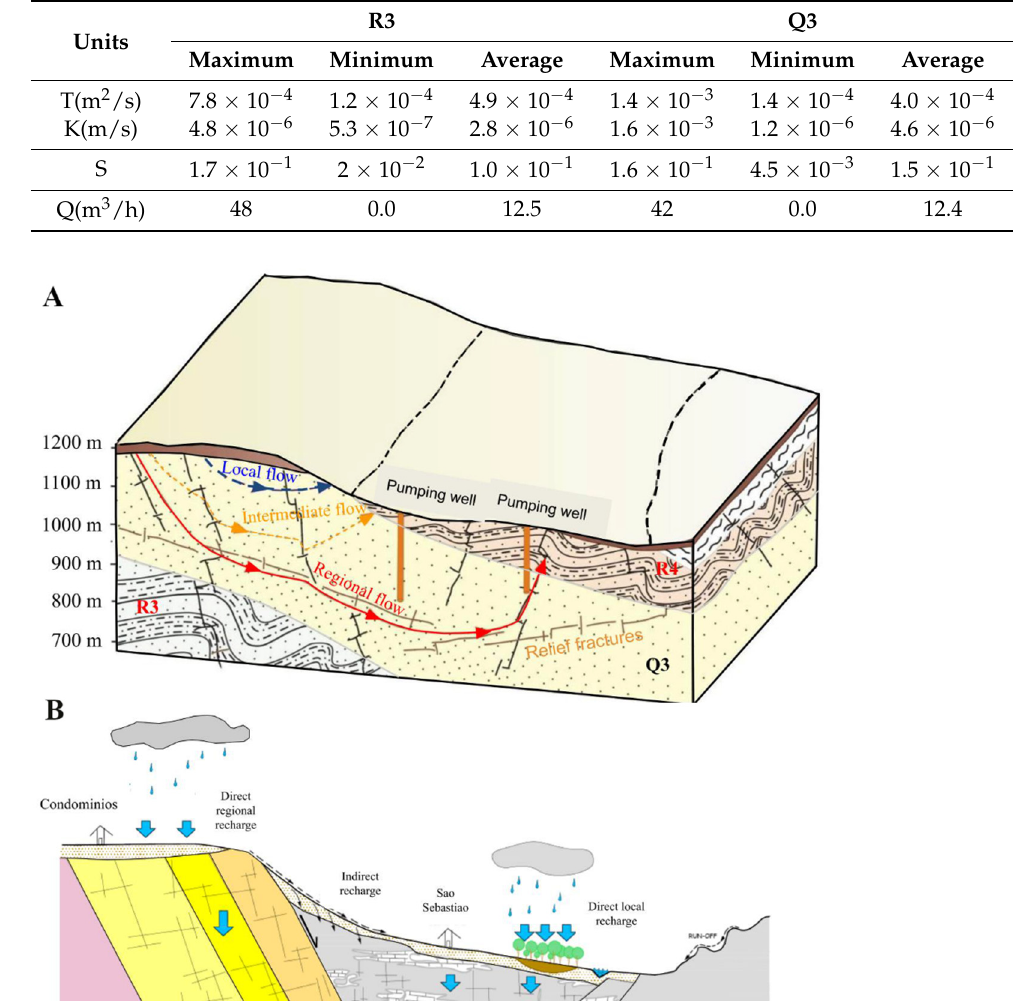
Table 2. Hydrogeological characteristics of the R3/Q3 aquifer sub-system. 24-h pumping test data of 27 deep pumping wells.